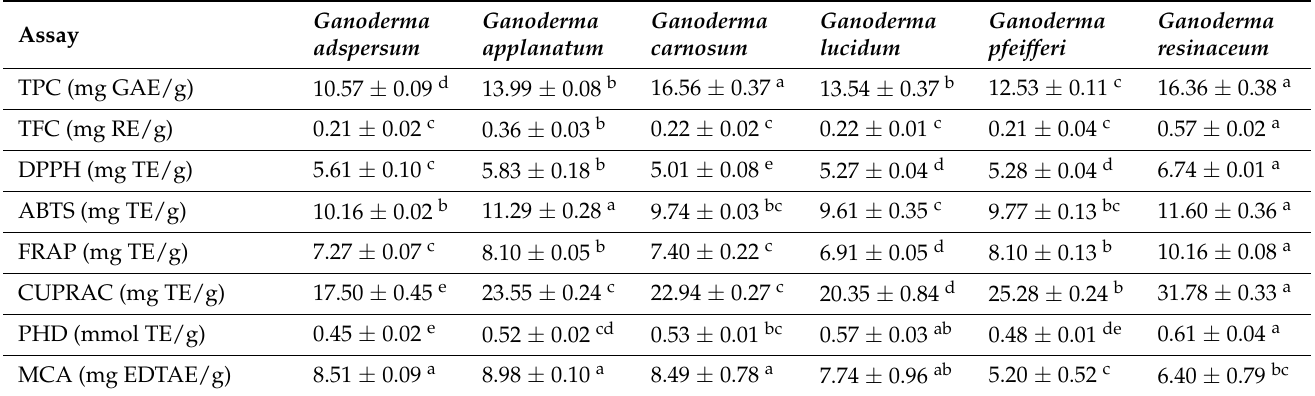
Table 2. Comparison of the total phenolic compounds, total flavonoid compounds, and antioxidant activity of biomass extracts using different methods